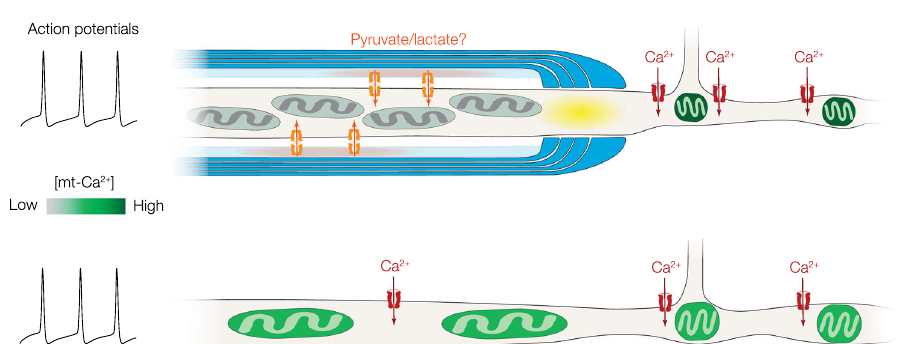
Fig. 9 | Summary of the impact of myelin on PV + axonal mitochondria. In normally myelinated PV + axons (top), mitochondria areclustered athigh densities to myelinated internodes (blue),possibly due to localdeliveryofnutrients such as pyruvate or lactate (orange) from cytoplasmic noncompacted myelin (light blue) to the axon. Internodal mitochondria avoid the fi rst ~2 µ m of the myelin sheath (paranodal domain, yellow), are relatively large, and display no or very weak